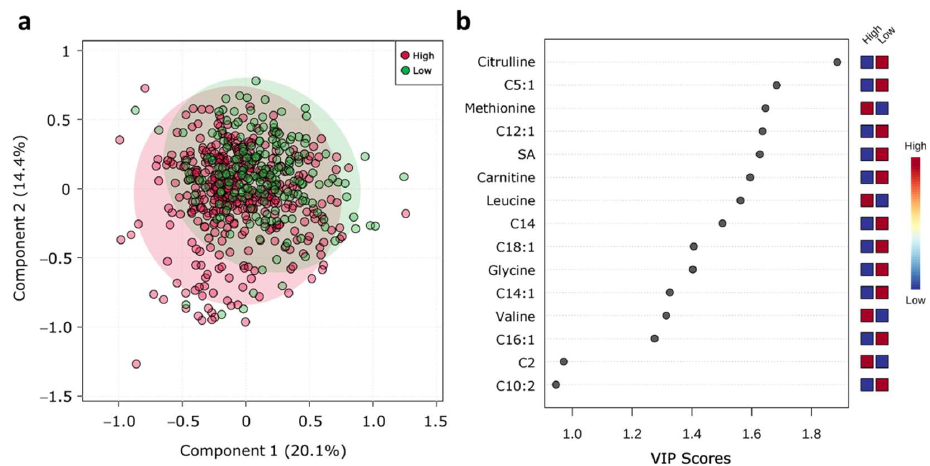
Figure 5. Serum metabolite profile according to BMD status. ( a ) PLS-DA plot shows separation between groups. Red circles represent individuals with high BMD; green circles represent individuals with low BMD. The explained variances are shown in brackets (accuracy 0.67; R2 0.11; Q2 0.069: permutation p -value < 5.0 × 10 −4 ); ( b ) VIP analysis represents the relative contribution of metabolites to the variance among groups. A high VIP score indicates a greater contribution of the metabolites to the group separation. Red and blue boxes indicate whether metabolite concentration is increased (red) or decreased (blue).